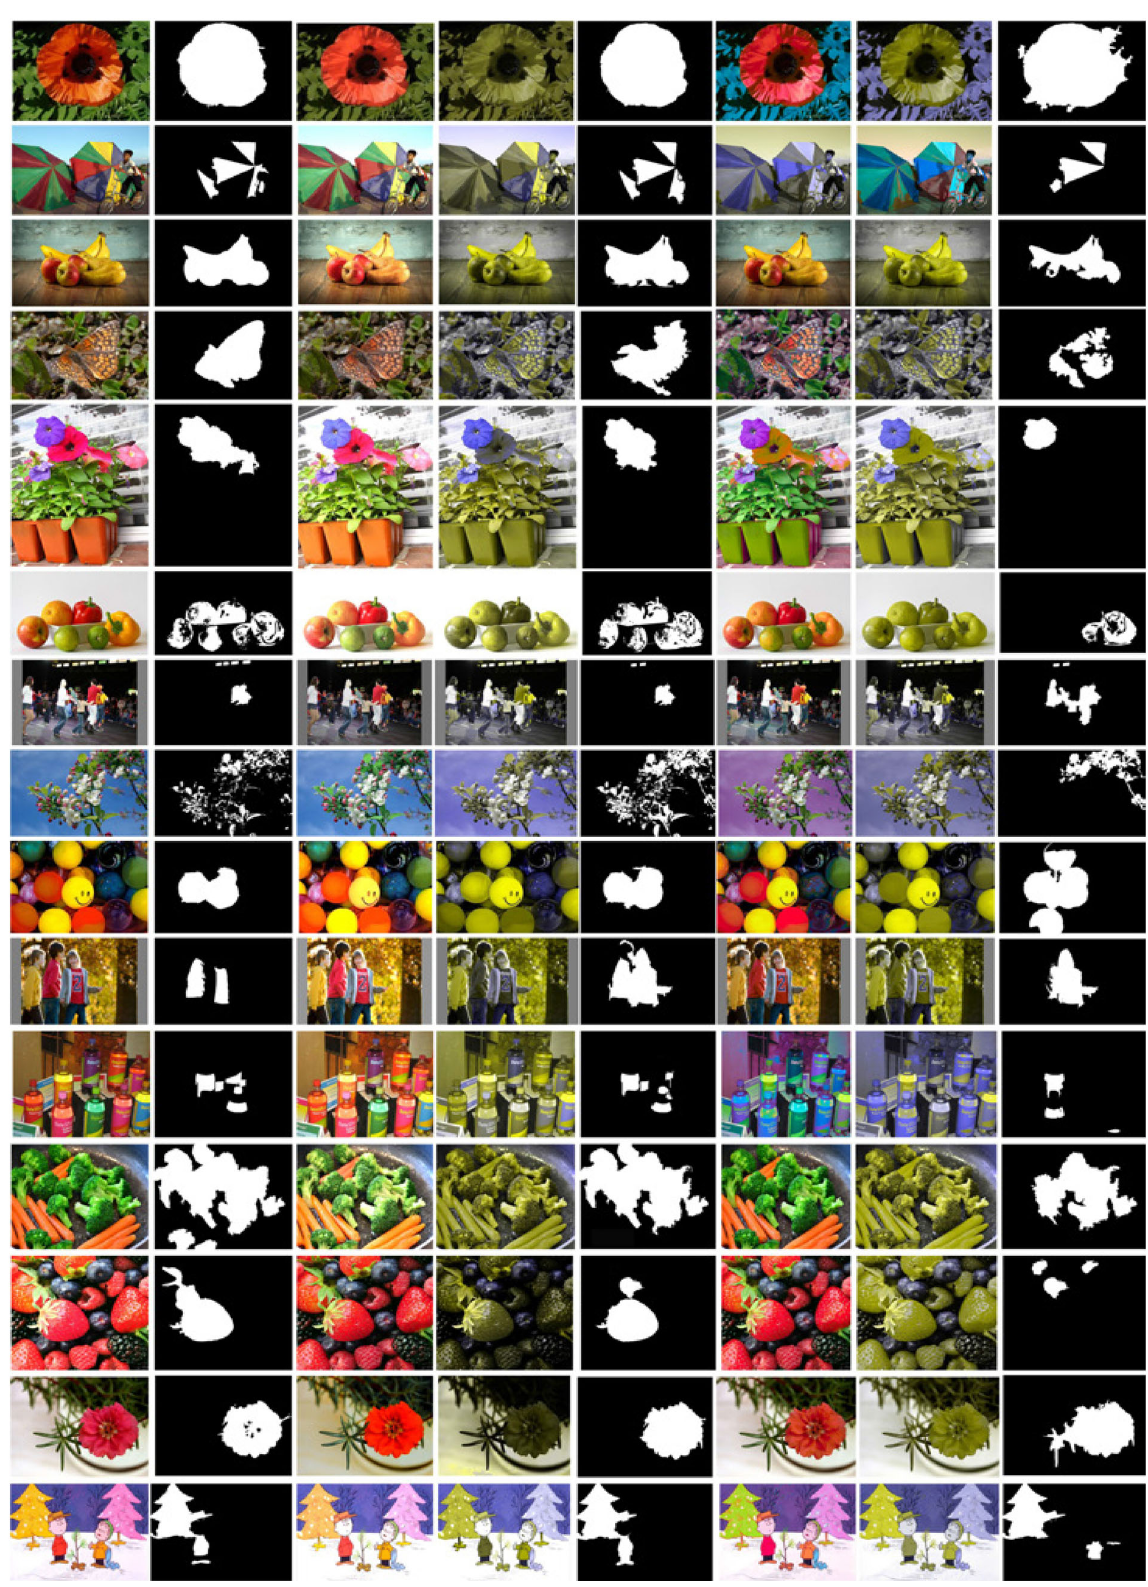
Fig. 9 For the deuteranopia image, compare our method with Huang’s color correction